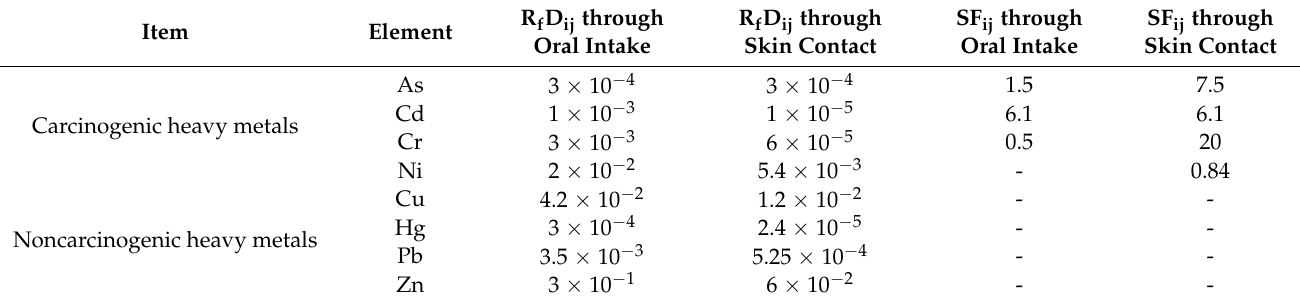
Table 5. Carcinogenic and noncarinogenic factors of heavy metals under different exposure